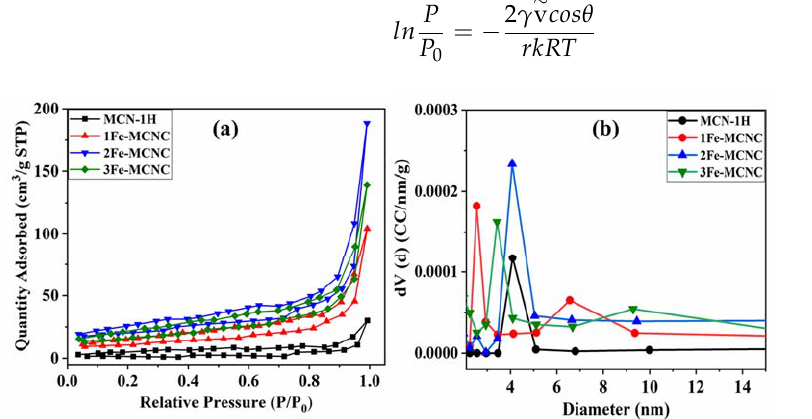
Figure 6. ( a ) The nitrogen adsorption–desorption BET isotherm, ( b ) pore size distribution of the MCN and Fe ‐ MCNC nanostructures. Table 2. BET analysis results of the surface area, pore volume, and average pore diameter of the MCN and Fe ‐ MCNC nanostructures. Samples